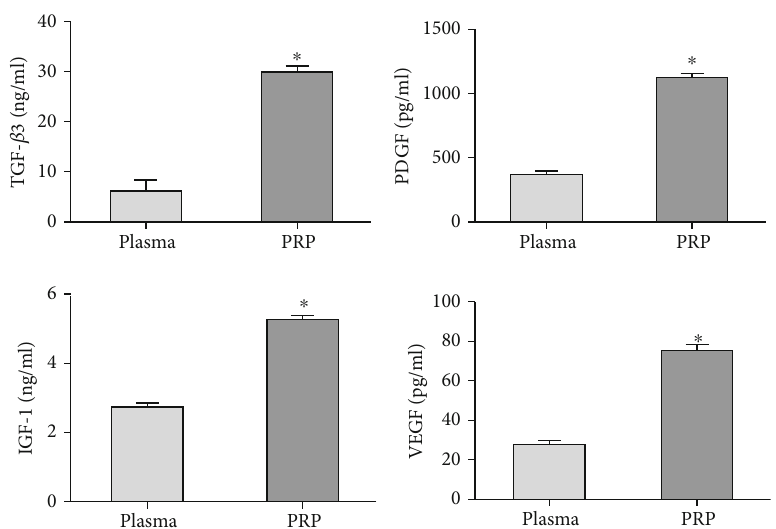
Figure 1: Growth factor levels in plasma and activated PRP. Concentrations of TGF- β 3, PDGF, IGF-1, and VEGF were signi fi cantly increased in PRP compared with plasma ( ∗ P < 0 : 05 , n = 6 ).